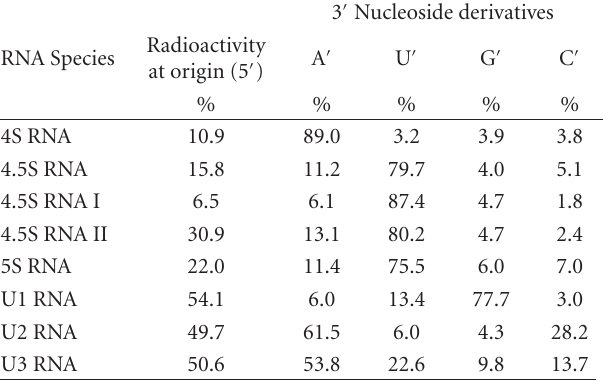
Table 9: The snRNA 2 (cid:2) and 3 (cid:2) -OH labeling by NaIO 4 oxidation and [ 3 H]-KBH 4 reduction [38]. The total 4–7S RNA from rat Noviko ff hepatoma cell nuclei was labeled with [ 3 H] by oxidation with NaIO 4 followed by [ 3 H]-KBH 4 reduction (Figure 12). Individual RNA species were purified by gel electrophoresis (Figure 13). The RNA samples were hydrolyzed with 0.3N KOH, and hydrolysates were chromatographed on whatman 3MM paper according to de Wachter and Fiers [55]. The radioactivities at the origin (22% for 5S RNA, 54.1% for U1 RNA, 49.7% for U2 RNA, and 50.6% for U3 RNA) represent % of total radioactivity applied and they represent the 5 (cid:2) end labeling which was later elucidated by many enzymatic methods described in the text. The radioactivities moved by chromatography with standard nucleoside derivatives are the % of total in nucleosides derivatives. The A (cid:2) U (cid:2) G (cid:2) C (cid:2) represent trialcohol derivatives of